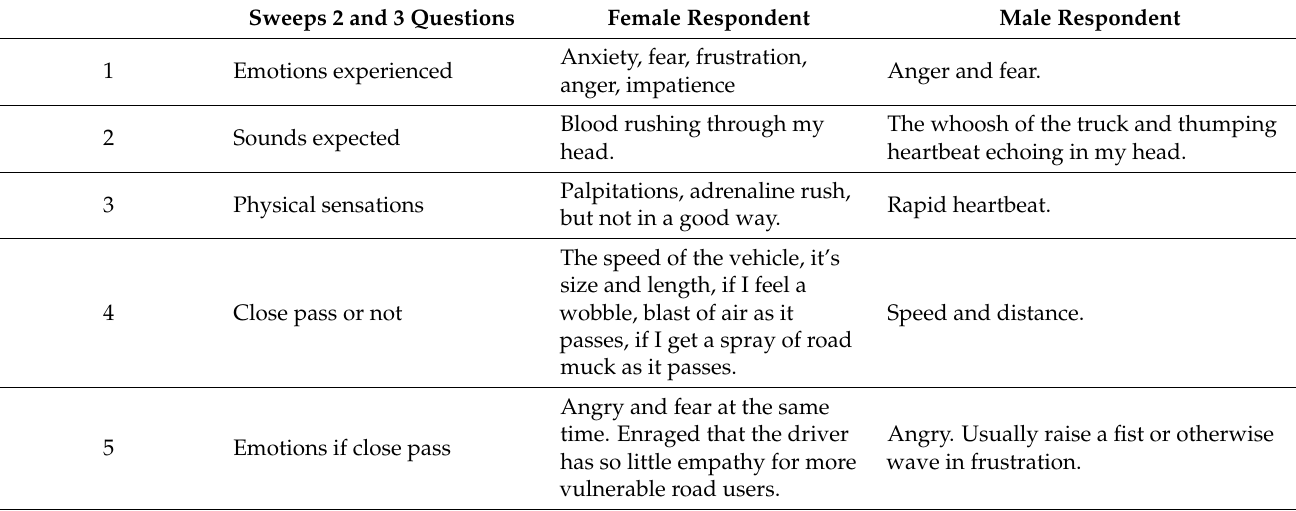
Table 2. Detailed analysis of two cyclists’